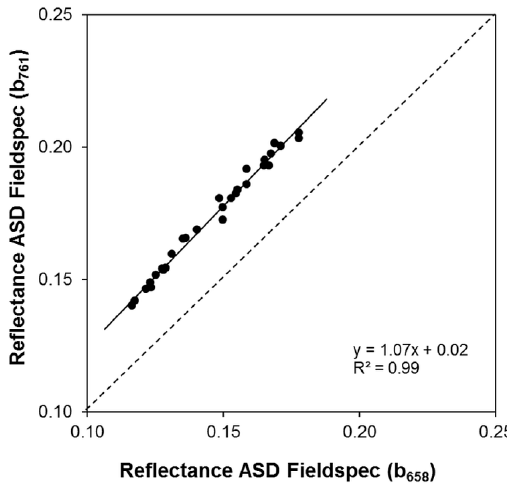
Figure 11. Relationship between ASD Fieldspec measurements of topsoil reflectance in the wavelengths corresponds to Mini-MCA 12 bands b 658 and b 756 .